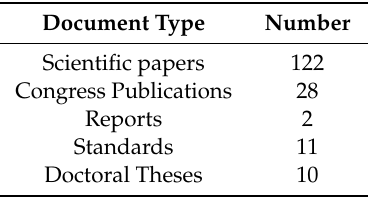
Table 1. Types and number of documents reviewed.